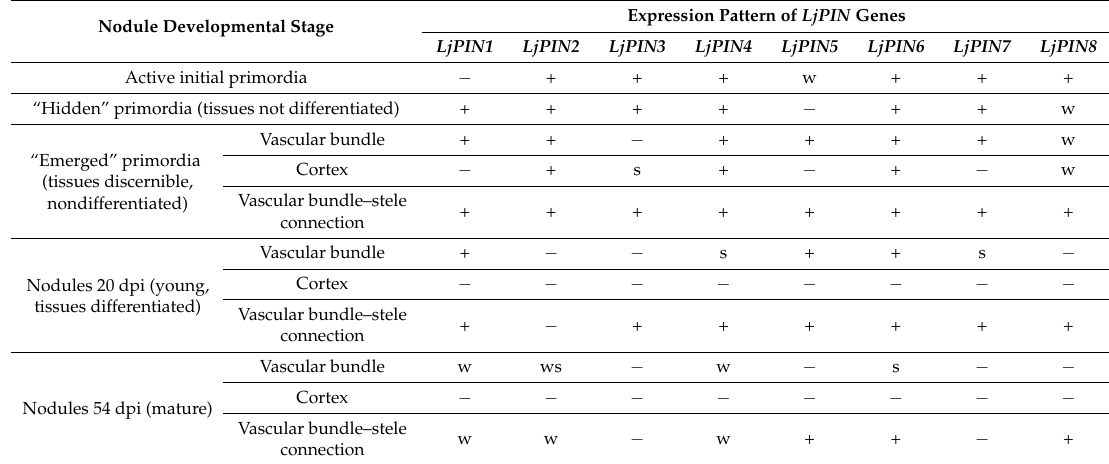
Table 2. Spatial expression pattern of LjPIN genes in relation to the root nodule developmental stage. “+,” signal; “ − ”, no signal; “w,” signal weak; “s,” signal